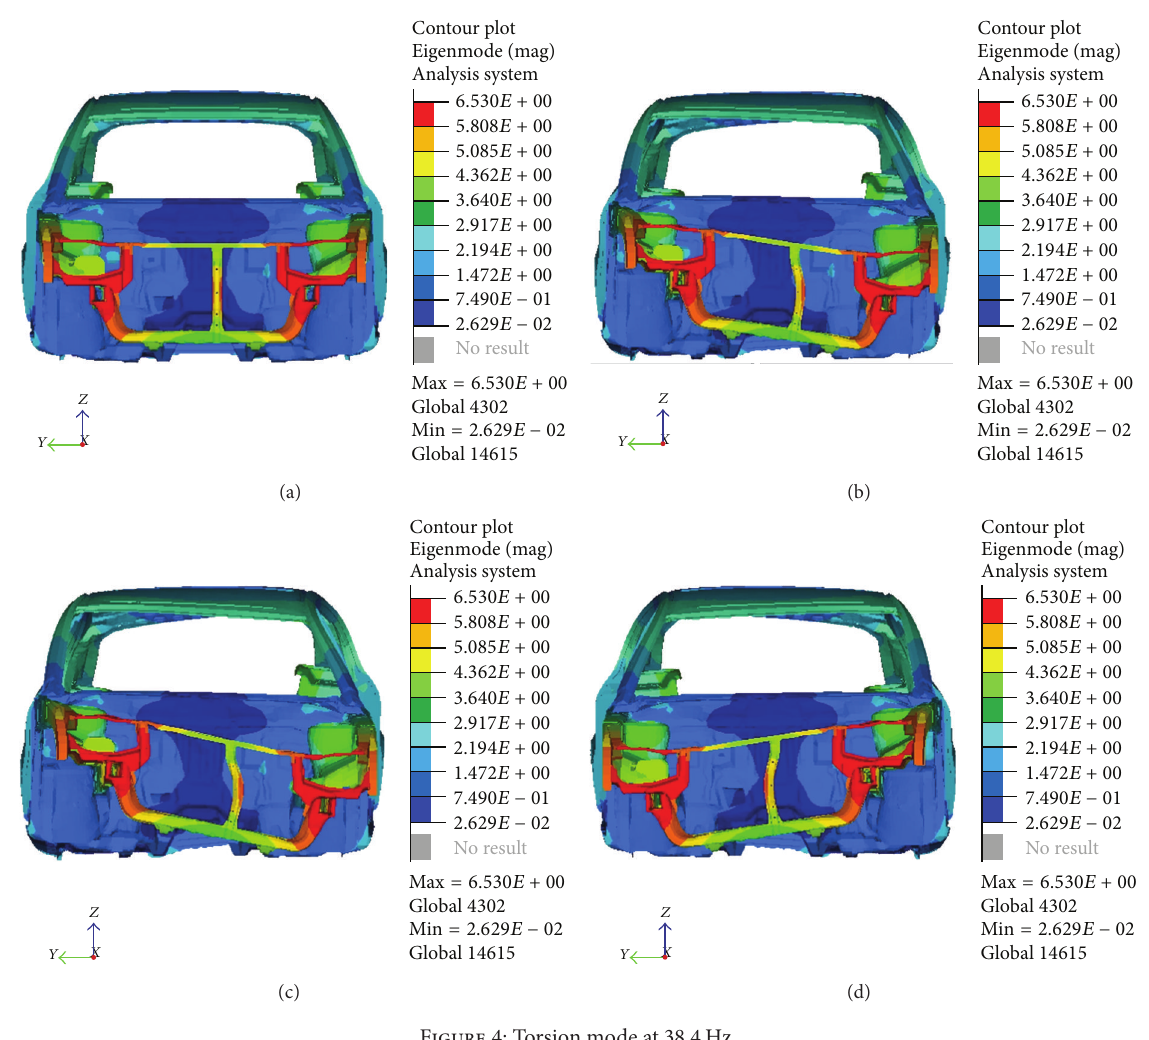
Figure 4: Torsion mode at 38.4